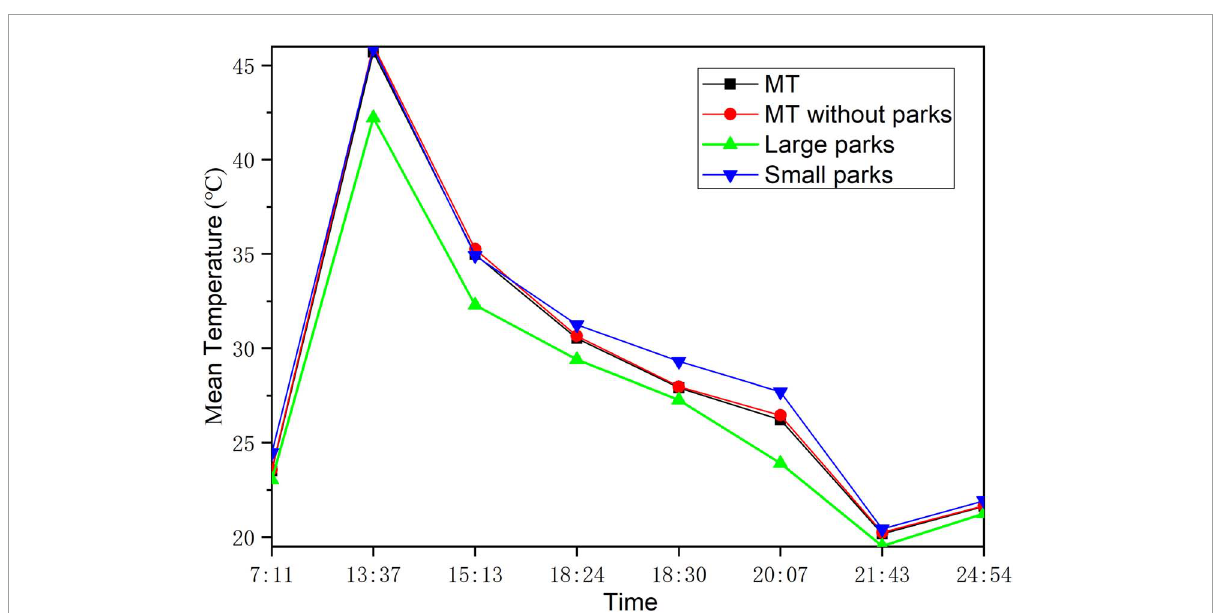
FIGURE2 Mean LST at different time in fifth ring. Mean temperature (MT) in fifth ring is shown in black line, in fifth ring without parks is in red line, in large parks ( > 40,000 m 2 ) is in green line and in small parks is in blue